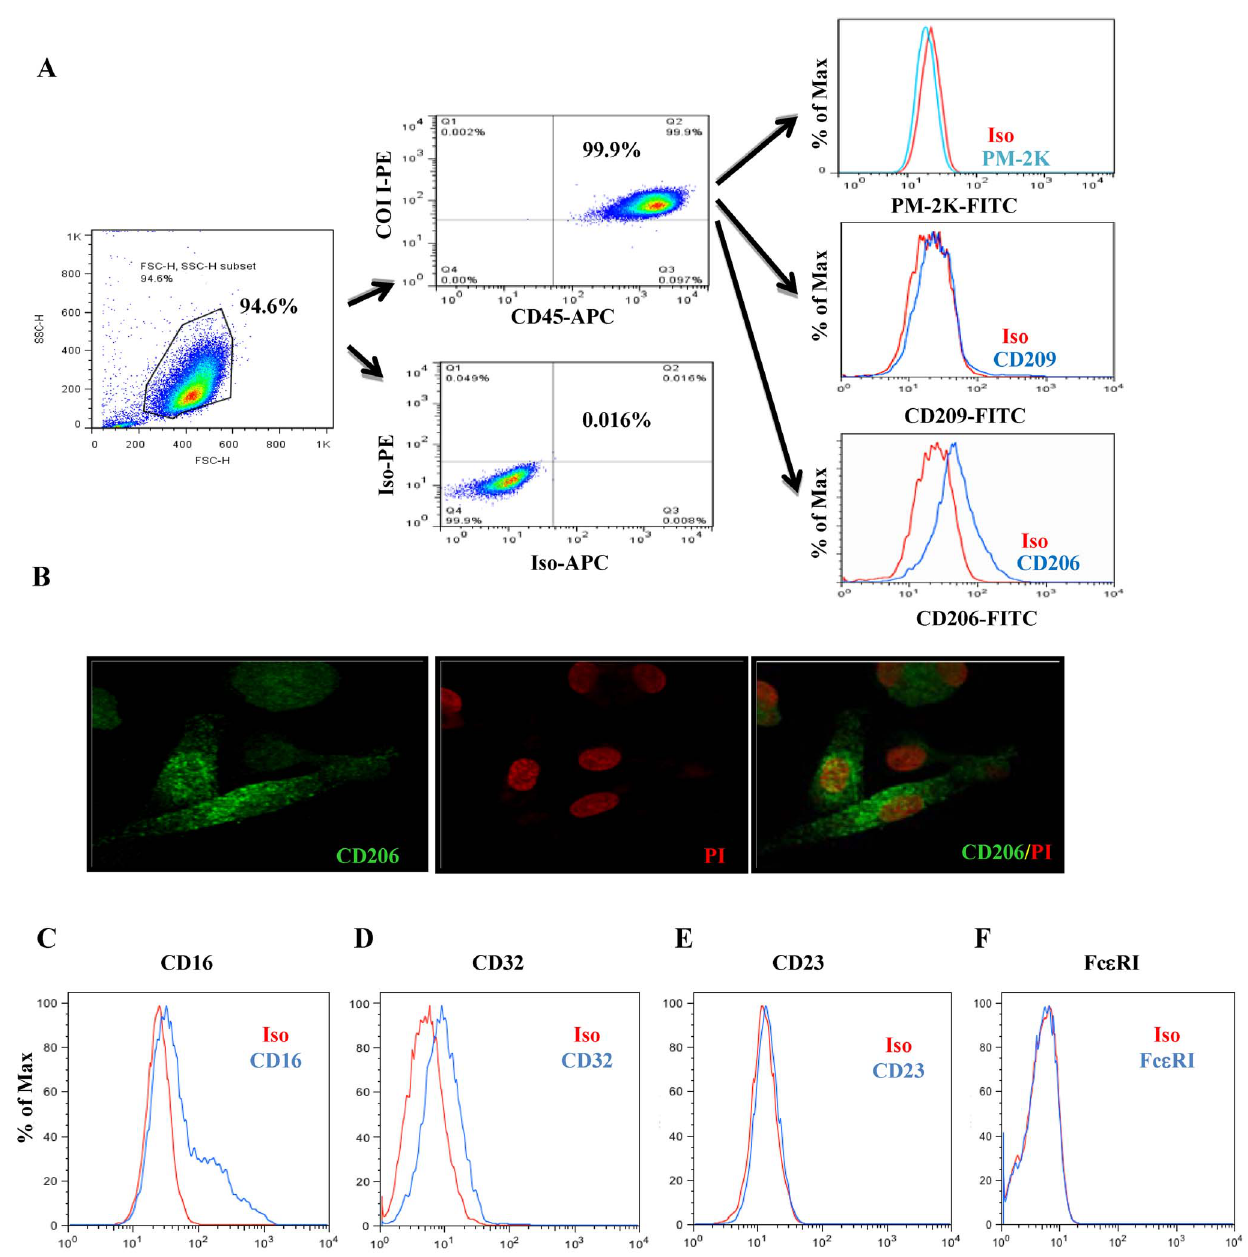
Figure 3. Characterization of human circulating fibrocytes. Co-expression of two fibrocyte markers CD45 and COI I in cultured human fibrocytes. ( A ) , 95% of cells showed co-expression of CD45 + and COI I + as determined by flow cytometry; those resting cells are negatively stained for macrophage marker PM-2K or DC marker CD209, but positive for CD206 in fibrocytes. ( B ) CD206 expression (green) in fibrocytes was further confirmed by confocal microscopy. Nuclear DNA is stained with propidium iodide (PI) (original magnification x60). Markers CD16 ( C ), CD32 ( D ), CD23 ( E ), and Fc e RI ( F ) were constitutively expressed on cultured fibrocytes detected by flow cytometry. Figures are representative of three independent